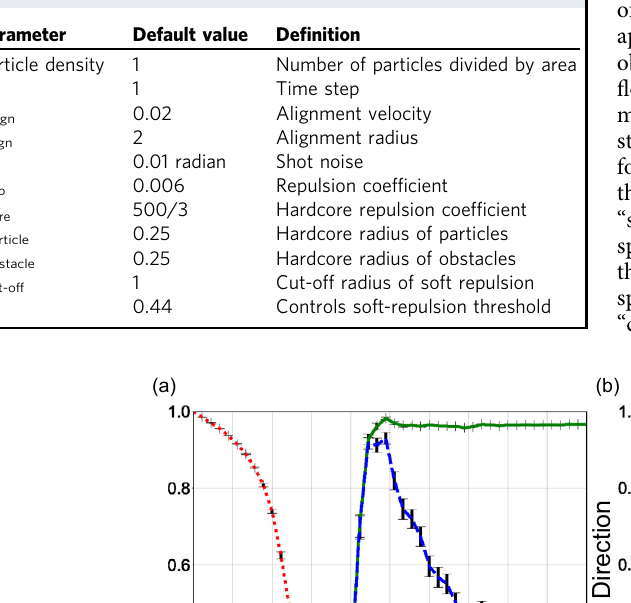
Table 1 Default value of the parameters.